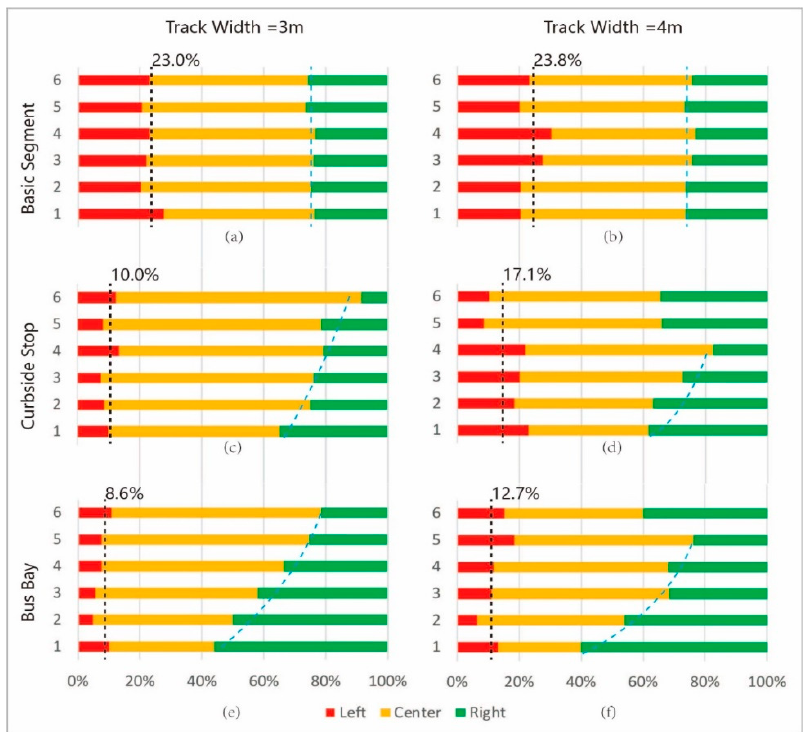
Figure 6. Differences in bike lateral distribution on ( a ) 3 m and ( b ) 4 m of tracks at basic segments, ( c ) 3 m and ( d ) 4 m of bypasses at curbside stops, and ( e ) 3 m and ( f ) 4 m of bypasses at bus bays.